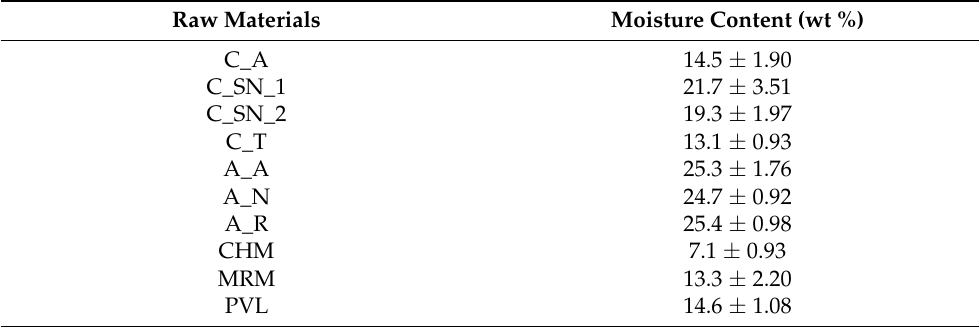
Table 1. Moisture content (wt %) of raw materials, as received in the laboratory. Raw